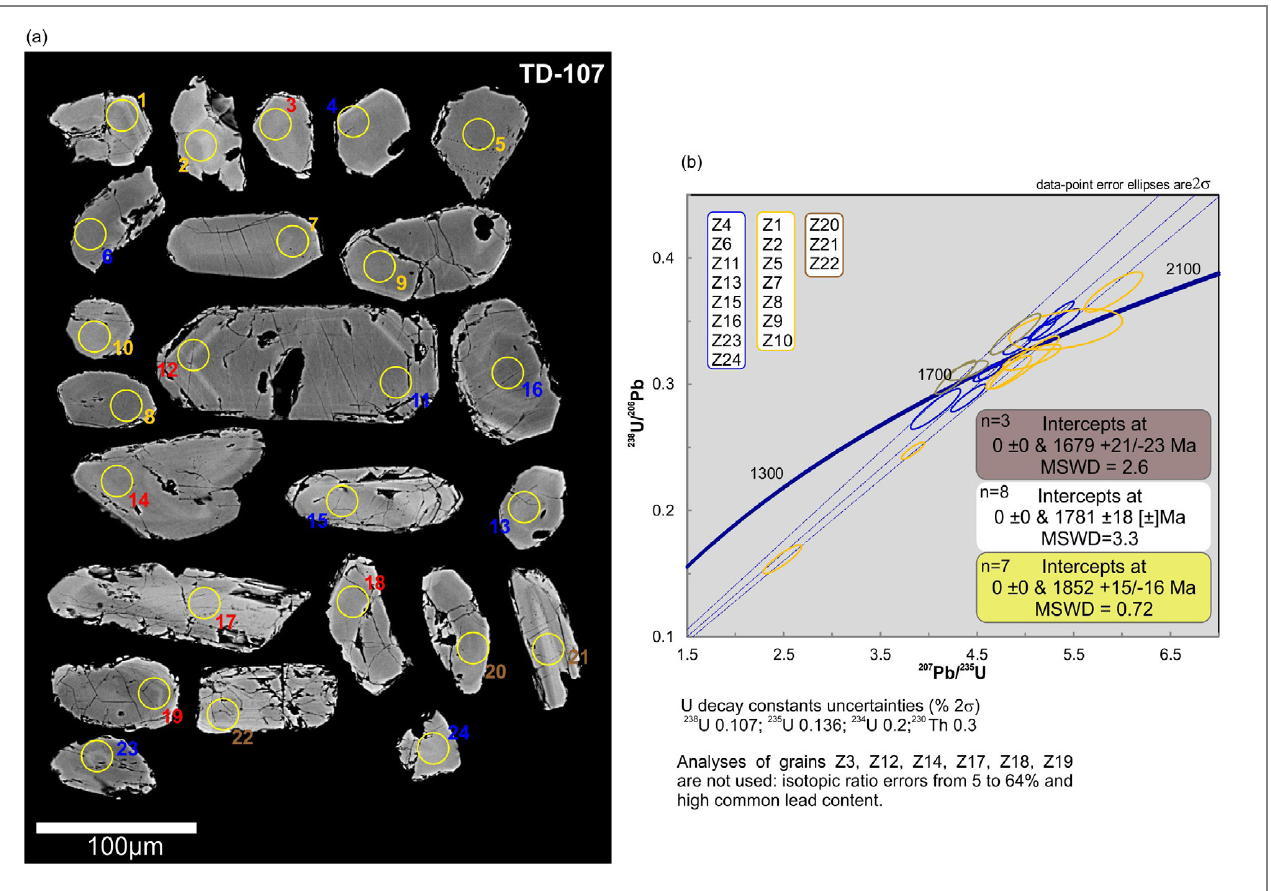
FIGURE 15 - (a) BSE image of zircons of an amphibolite (sample TD-107) from the Colíder Group showing the morphological features, location and ID of pits; and (b) U-Pb concordia diagram and the upper intercept age calculated. The spots marked in blue, brown and yellow were used in the calculations of the middle, younger and older upper intercept ages respectively. The spots marked with red number were not used in the